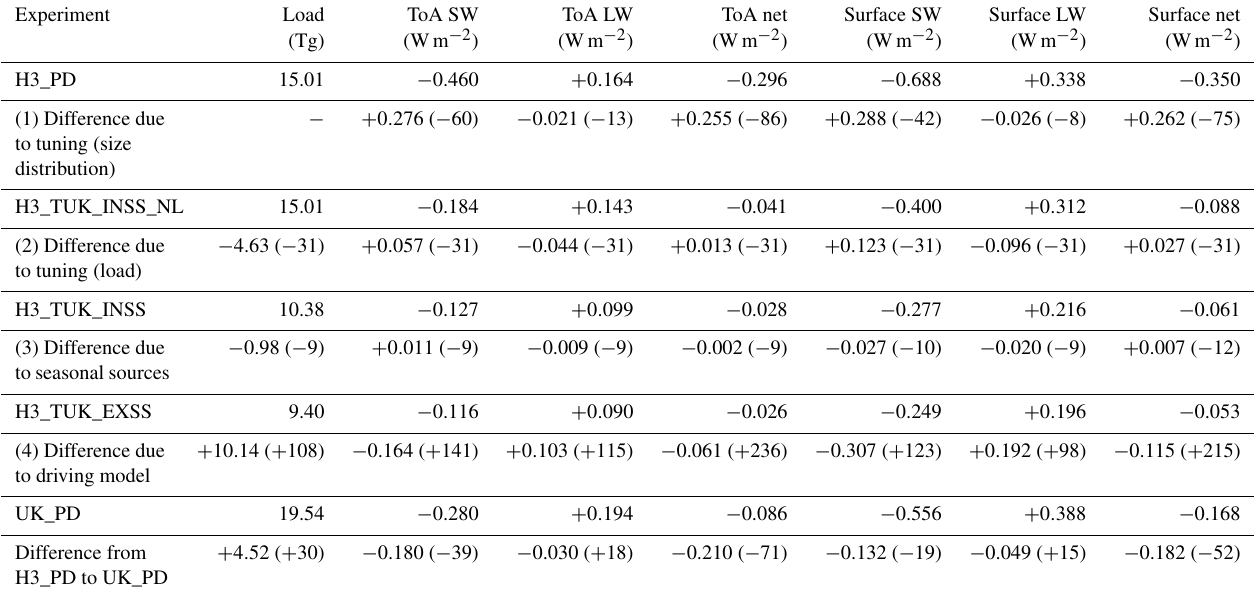
Table 2. Global mean load and all-sky direct radiative effects, due to dust in a present-day climate, from various experiments. Alternate rows show experimental results and the absolute differences, followed by percentage differences (in parentheses) between the experiment below and the experiment above.